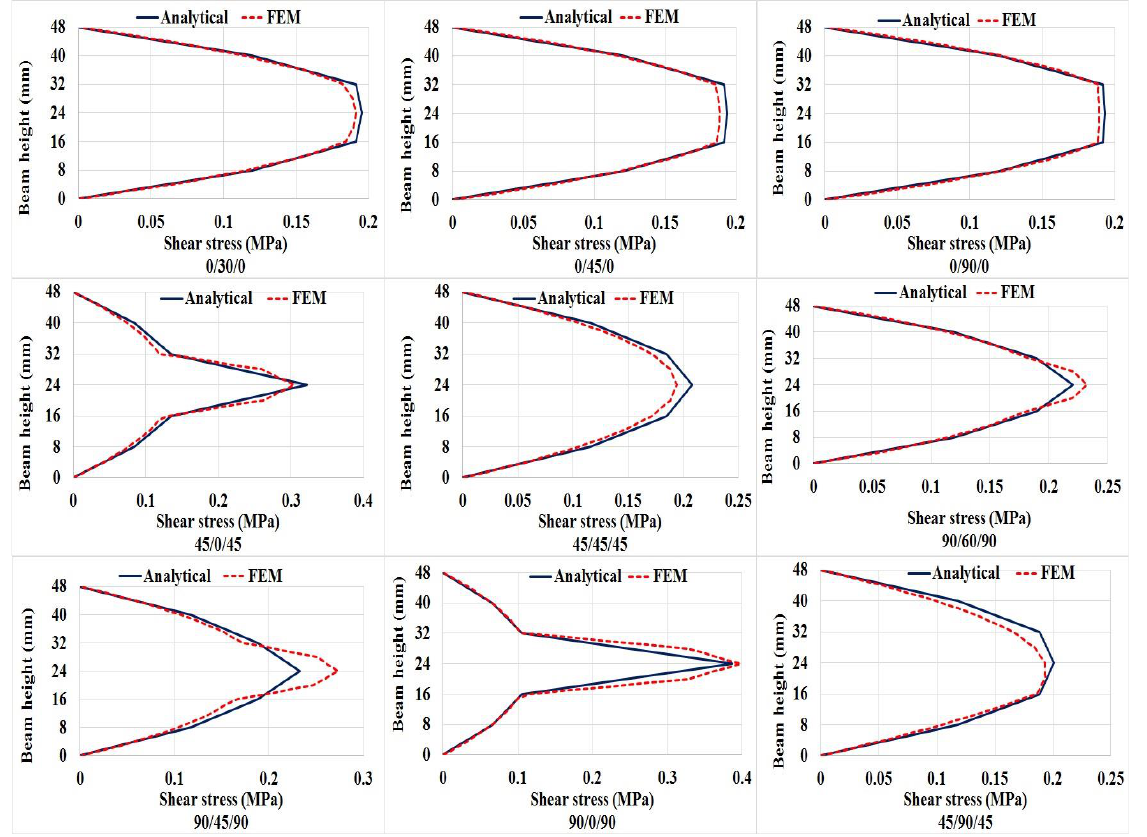
Figure 9. The shear stress distribution of CLTs with different arrangements of layers.